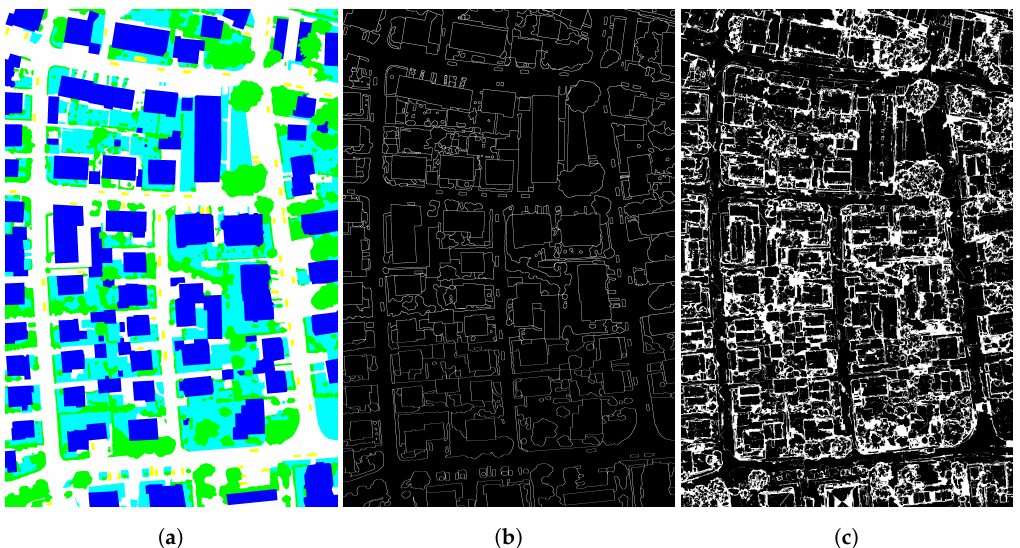
Figure 5. Object borders are characterized with low confidence: ( a ) reference segmentation map, ( b ) borders of the reference objects, and ( c ) super-pixels with